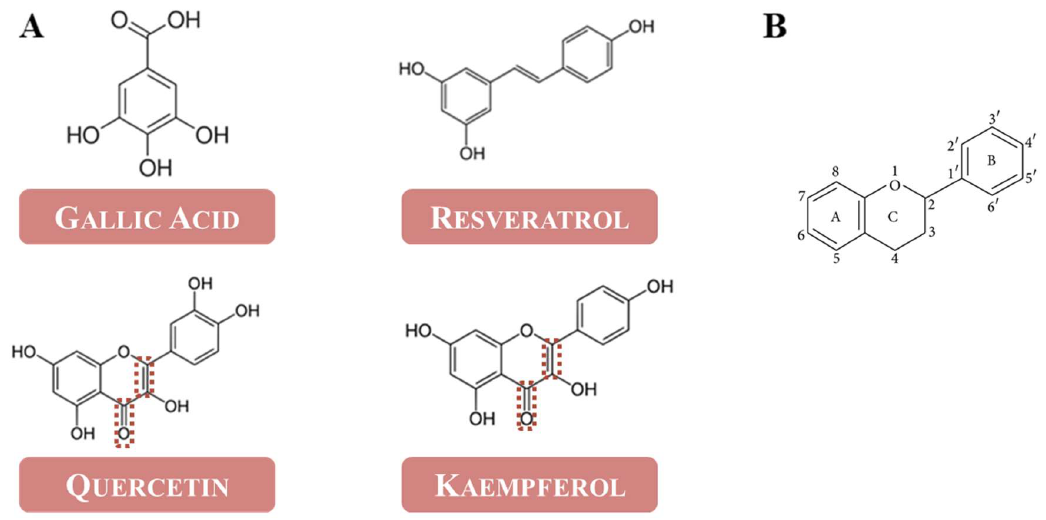
Figure 3. ( A ) Molecular structure of the analyzed phenolics in OP and PFP extract; ( B ) basic structure of flavonoids.